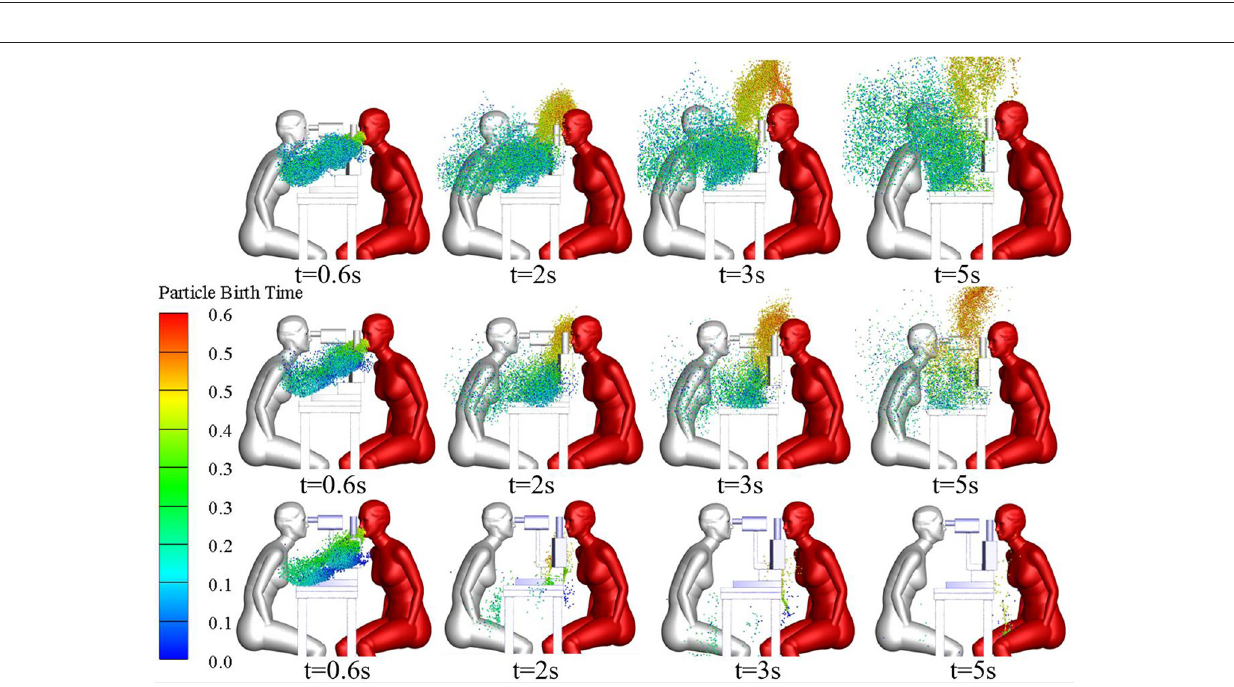
FIGURE 10 | Comparison of droplet distributions with initial droplet diameters of 50, 70, or 100 µ